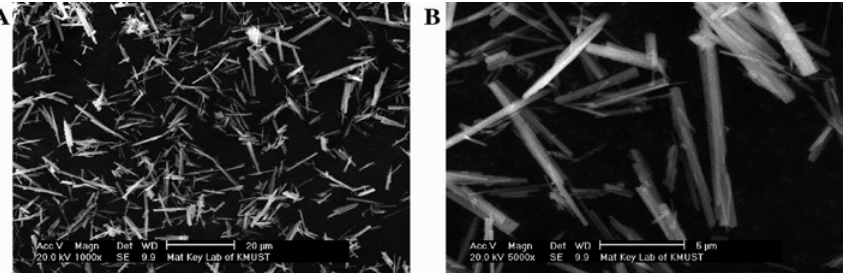
particles prepared under optimal experimental conditions by homogeneous precipitation method. Figure 7: SEM photos of BaCO 3 (A) 1000 × ; (B) 5000 × .